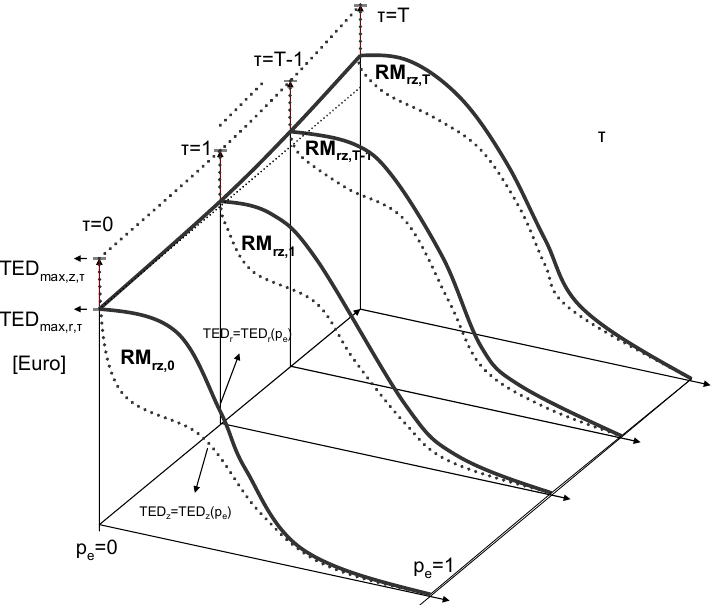
Figure 6. Graphical representation of the risk mitigation performance strategy z , assuming variability in damage potential and risk mitigation performance through